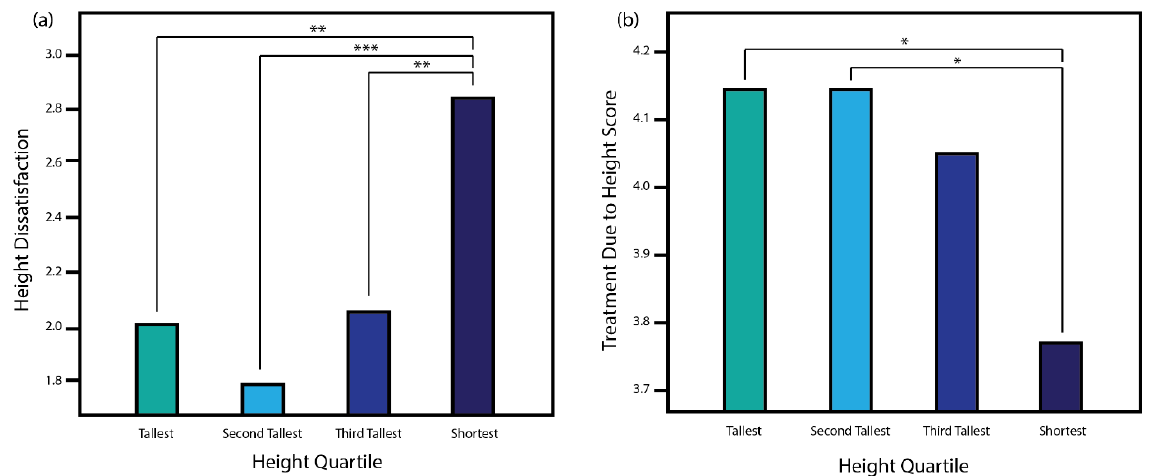
Figure 1. Differences in ( a ) height dissatisfaction and ( b ) treated differently due to height score across quartiles of self- reported height. Note: * p < 0.05; ** p < 0.01; *** p <